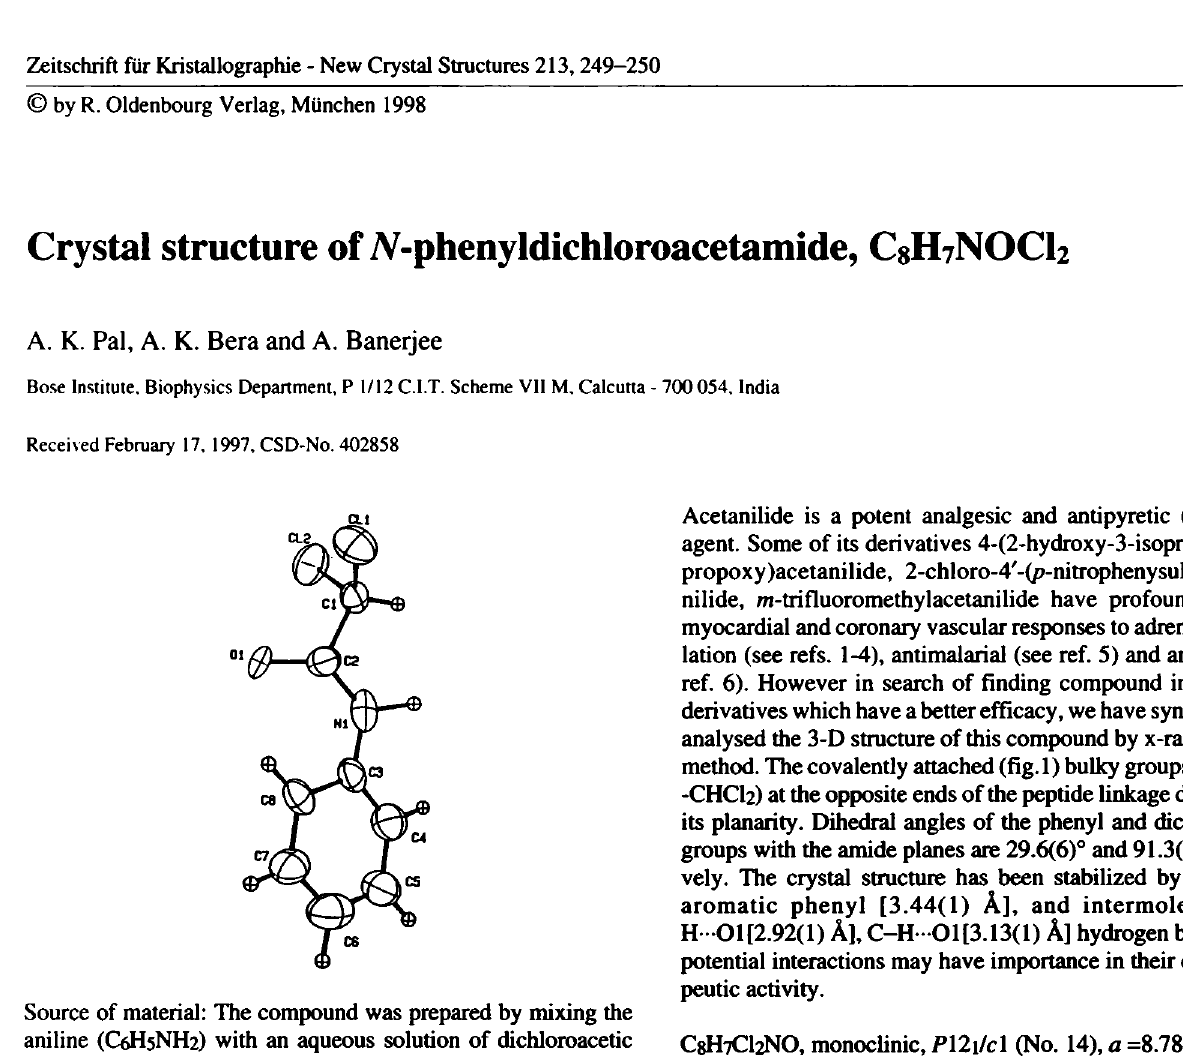
Table 1. Parameters used for the X-ray data collection